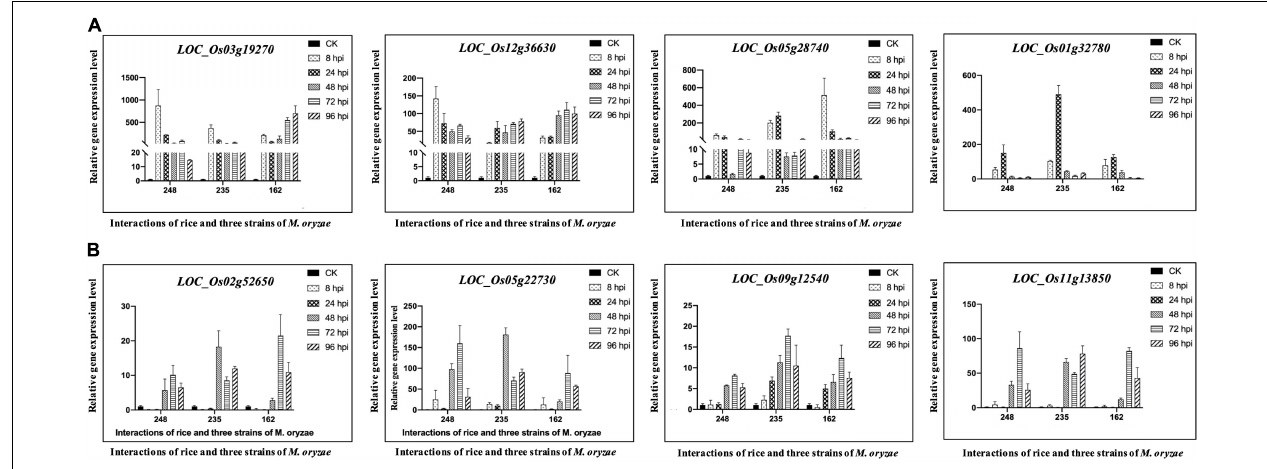
FIGURE 5 | Quantitative Real-Time PCR verification of expression of selected coding genes of Light-harvesting chlorophyll a/b-binding proteins and universal stress proteins in O. sativa L. ssp. japonica cv. Nipponbare (Nip) during interactions with Magnaporthe oryzae 248, 235, and 162. Un-incubated Nip plant was used as the control sample and normalized to 1.0. The actin genes of Nip ( LOC_Os03g50885 ) were used as internal reference genes. Data displayed as the average of three biological replicates and error bars indicate standard deviations. 8, 24, 48, 72, and 96 hpi represent hours post-incubation with three M. oryzae strains. (A) Quantitative Real-Time PCR verification for Light-harvesting chlorophyll a/b-binding proteins coding genes in Nip. (B) Quantitative Real-Time PCR verification for universal stress protein-coding genes in Nip.